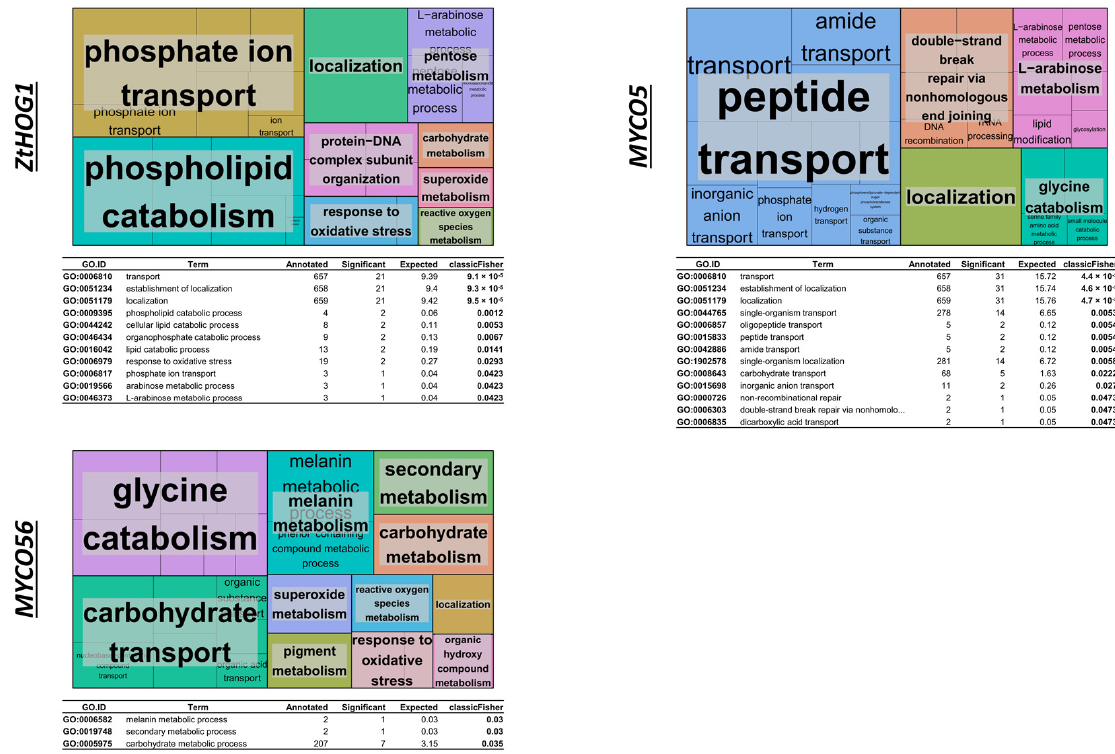
Figure 4. GO enrichment analysis of differentially expressed genes in ∆ Zthog1 , ∆ myco5 and ∆ myco56 . GO terms enriched in the DE genes for each of the mutant strains studied ( ZtHOG1 , MYCO5 and MYCO56 ) were analyzed with the aid of the TopGO package in R, and the first fifty GO clusters were processed by using the web-based tool REVIGO. GO terms’ redundancy was subtracted, and the GO terms for biological processes were clustered in TreeMap plots, where each rectangle represents a single cluster. Similar colors of the rectangles indicate semantic similarity. The magnitude of the rectangles reflects the p -value obtained from TopGO analysis (the larger the size, the smaller the p -value and the greater the enrichment factor for respective GO term). For the TreeMaps, the adjoining table shows those GO clusters identified by using TopGO evaluation and which were significantly enriched according to classic Fisher analysis with a p -value ≤